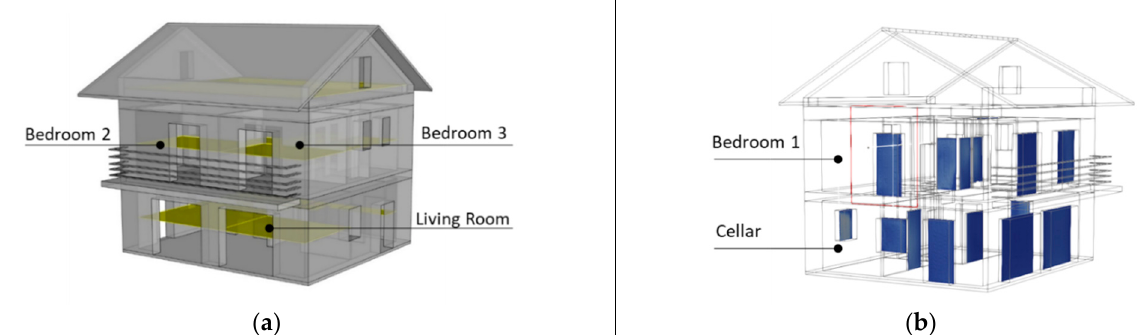
Figure 7. Post-processing calculation planes. ( a ) Horizontal—room air velocity (m/s); ( b ) Vertical—Integration method: ACH.